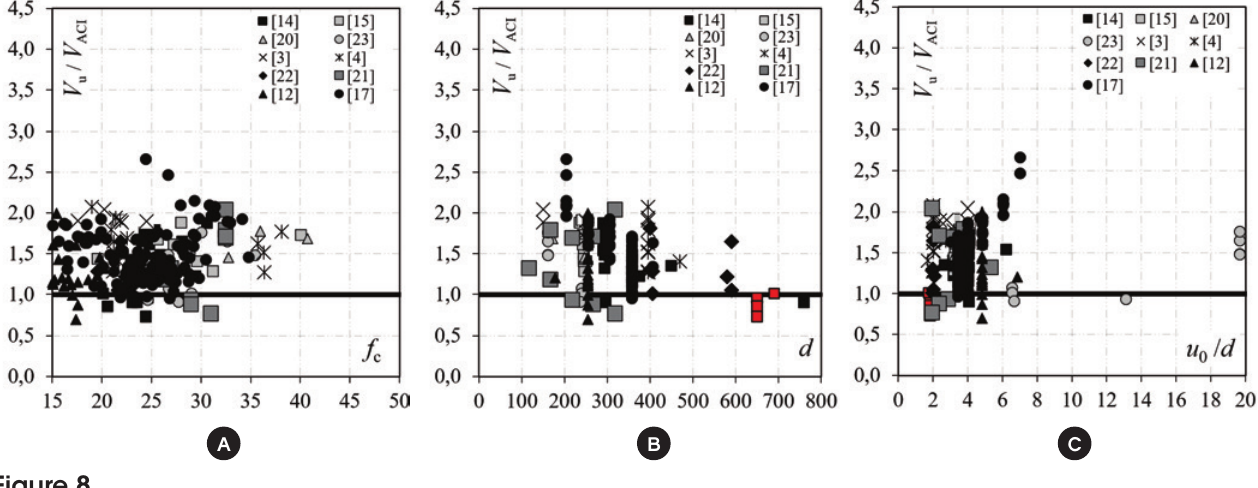
Comparison between experimental results and the recommendations of ACI 318